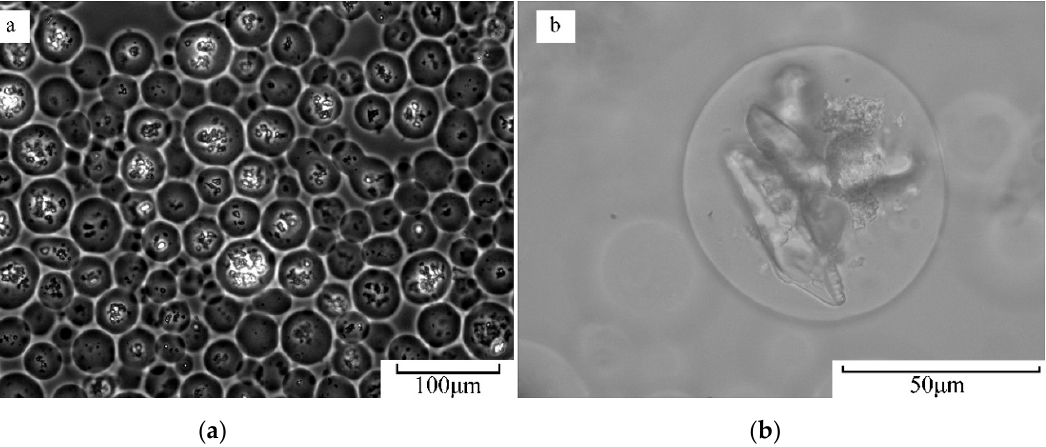
Figure 1. Wet microcapsules under an optical microscope : ( a ) microcapsules contain small crystals, ( b ) Microcapsules contain large crystals.